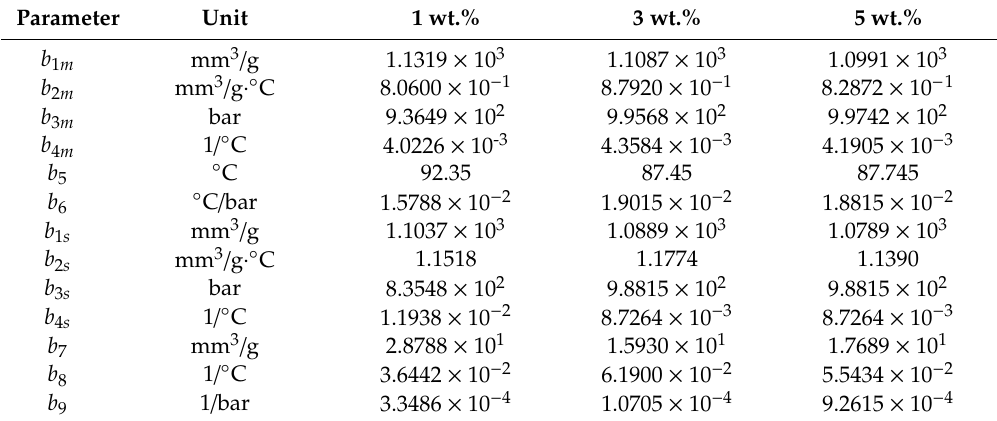
Table 3. Tait parameters for EVA/MWCNT composite.